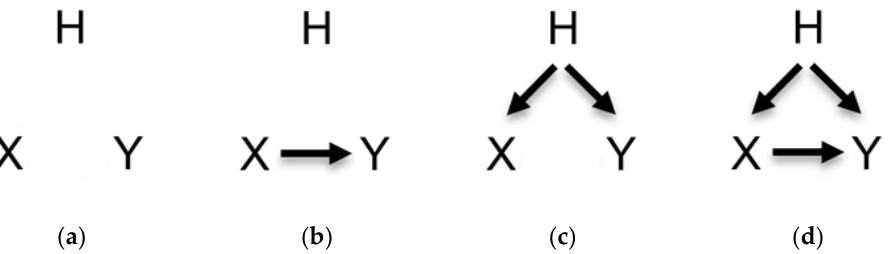
Figure 4. Four pairwise causal relationships. H represents a variable that is shaded, meaning that it is present in the ALARM network but not introduced in the datasets using C9 and S9. Not confounded and not causally related is denoted as Ø X Y in ( a ). Not confounded and causally related is denoted as Ø X → Y in ( b ). Confounded and not causally related is denoted as H X Y in ( c ). Confounded and causally related is denoted as H X → Y in ( d ).